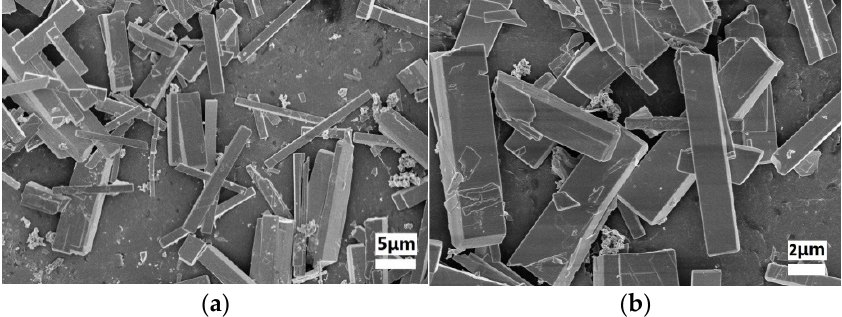
Figure 3. SEM images of the BiMRs under different magnifications, ( a ) 2000 times and ( b ) 5000 times.